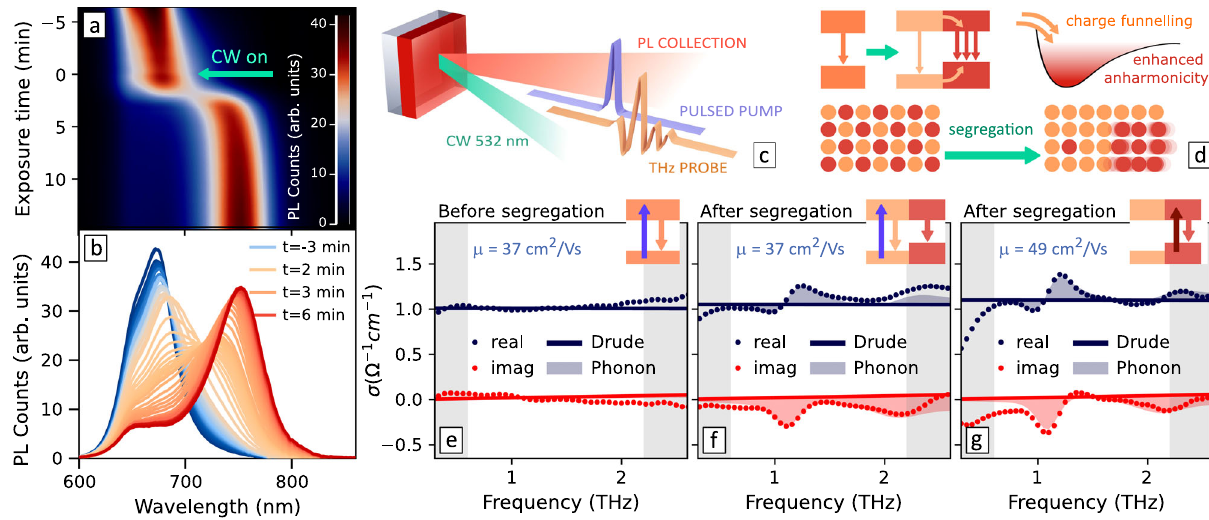
Fig. 1 Phase segregation of mixed halide perovskites monitored by optical-pump terahertz-probe spectroscopy. a , b PL spectrum evolution over time under 400 nm pulsed illumination, collected in situ during the OPTP experiment, as illustrated in ( c ). Exposure to the CW laser starts at t = 0. d Diagram illustrating the effect of halide segregation with enhanced anharmonicity in the I-rich phase. The band diagram is for illustration purposes and does not mean to provide an accurate description of band alignment. e – g THz photoconductivity spectra of the MAPb(I 0.5 Br 0.5 ) 3 thin fi lm at 5 ps after photoexcitation with 400 nm pump before ( e ) and after ( f ) phase segregation, and with 720 nm photoexcitation directly into the segregated I-rich phase ( g